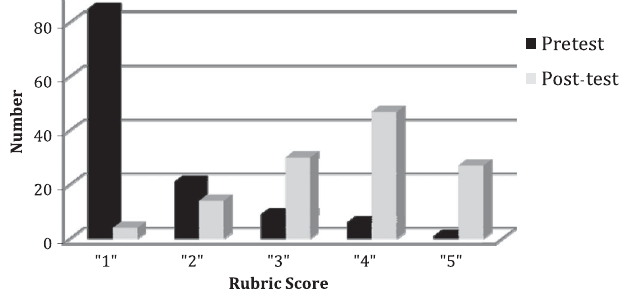
FIG. 2. Distribution of rubric scores for preservice immersion participants on the pretest and post-test ( N ¼ 122